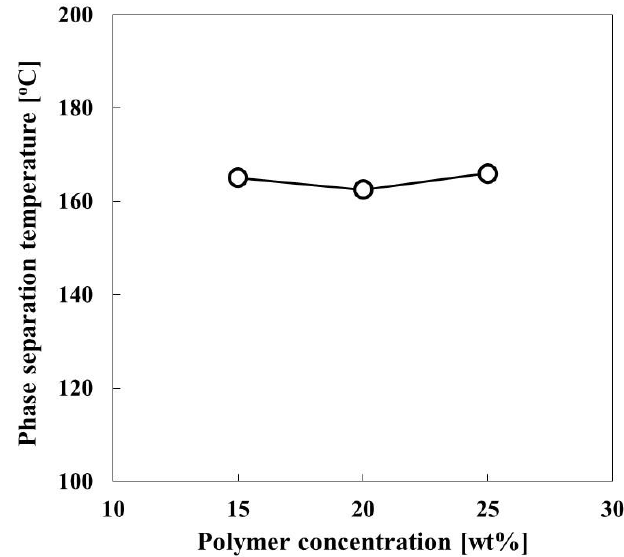
Figure 3. Phase diagram of CBzOH/1,3-BG solutions.